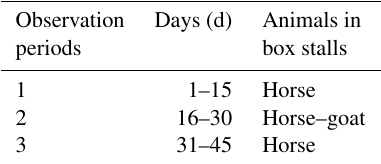
Table 1. Observation periods and days in the box